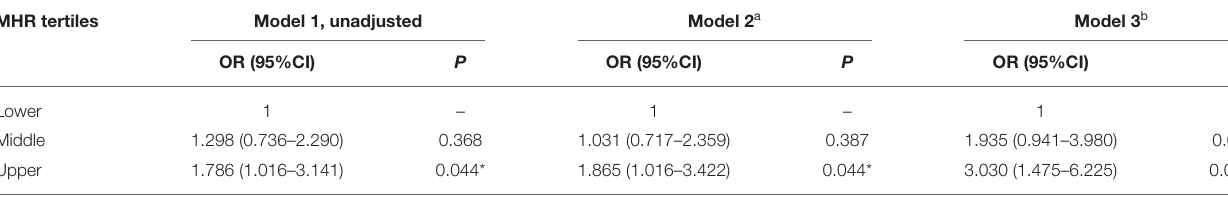
TABLE 3 | Univariate and multivariate logistic analyses of the association between MHR and 3-month poor outcome. MHR tertiles